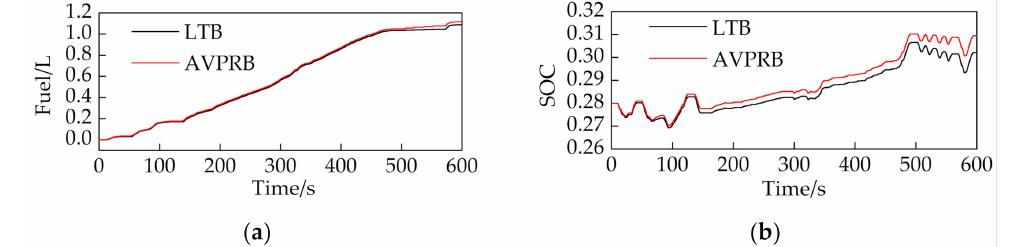
Figure 17. Fuel consumption and SOC of the two strategies under the US06 cycle: ( a ) fuel consump- tion; ( b ) SOC